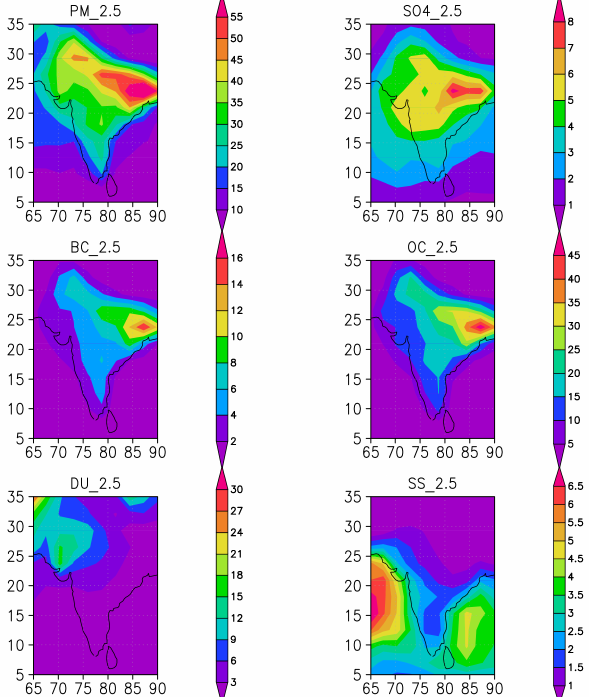
Fig. 2. Total surface PM 2 . 5 in India and contributions to it from different aerosol species (four-year average (2006–2009), in units µgm − 3 ).